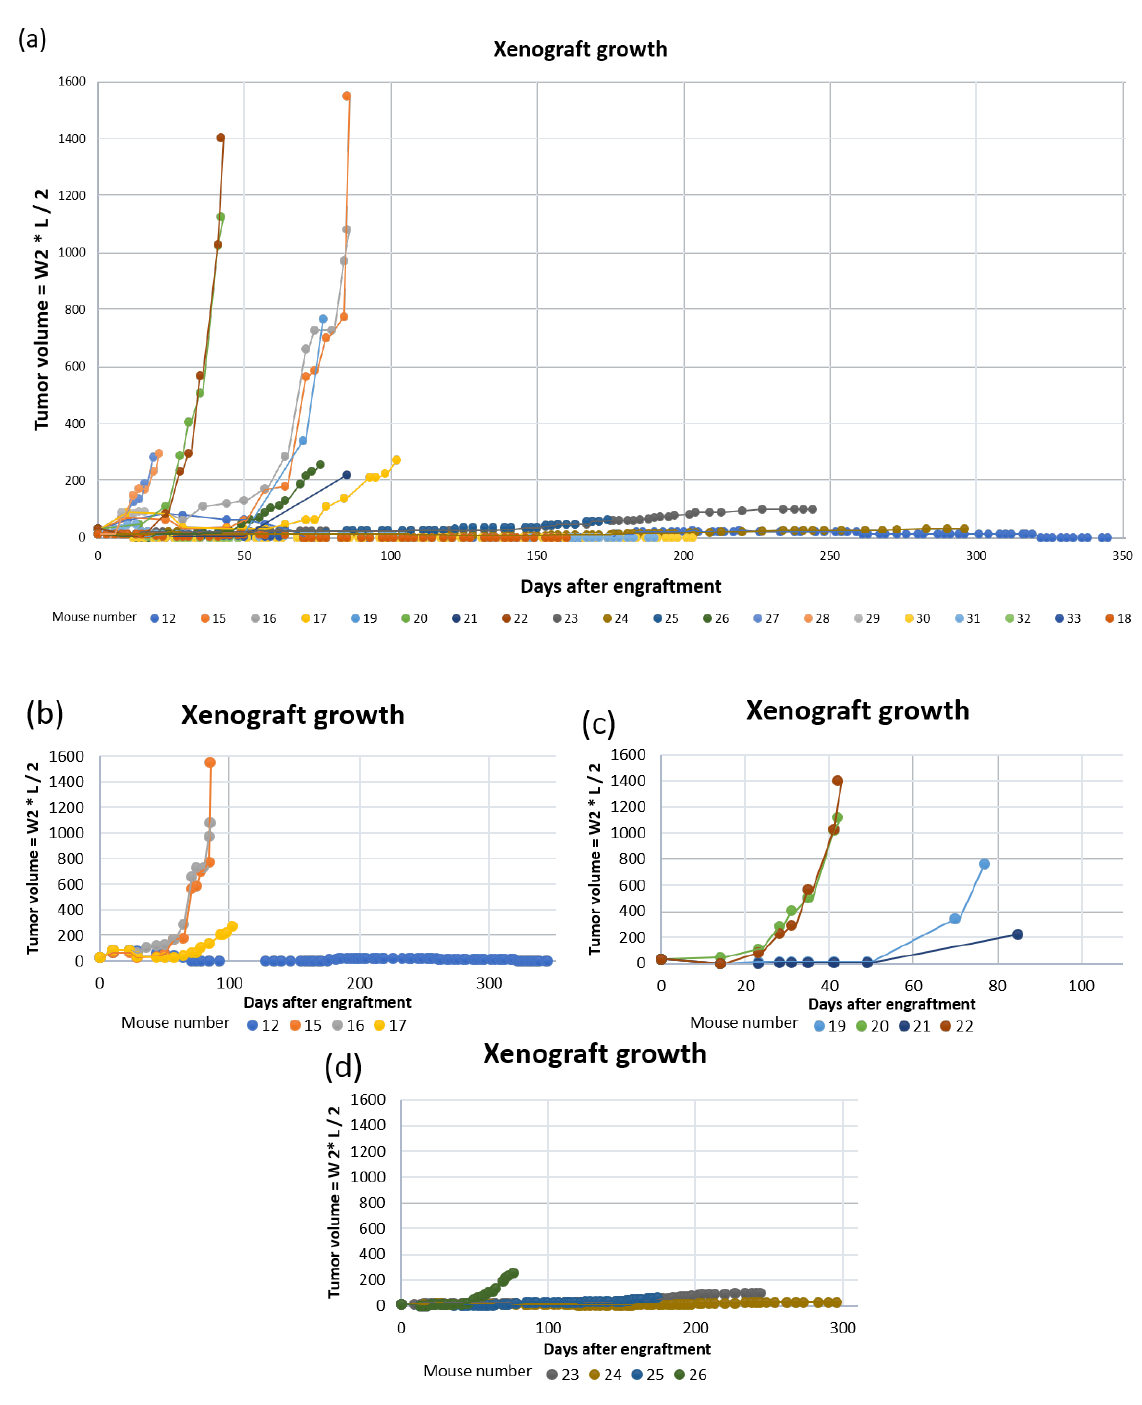
Figure 8. PDX growth curves for: ( a ) all mice; ( b ) mouse #12, 15, 16 and 17 (tumor fragments from patient 3); ( c ) mouse #19, 20, 21 and 22 (tumor fragments from patient 11) and; ( d ) mouse #23, 24, 25 and 26 (tumor fragments from patient 17).